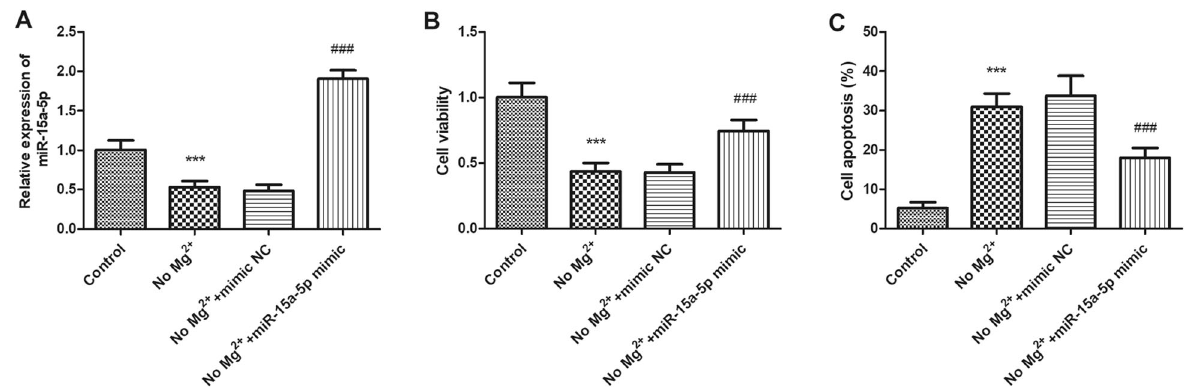
Fig. 4 The effect of miR-15a-5p on the viability and apoptosis of hippocampal neuron. a . Transfection of miR-15a-5p mimic lead to a remarkable increase in the expression level of miR-15a-5p. b . The viability of hippocampal cells treated in the magnesium-free medium was significantly reduced which was reversed by miR-15a-5p mimic transfection. c . The cell apoptosis of hippocampal cells treated in the magnesium-free medium was significantly increased, overexpression of miR-15a-5p attenuated TLE-induced cell apoptosis. *** P < 0.001, compared with control group; ### P < 0.001, compared with No Mg 2+